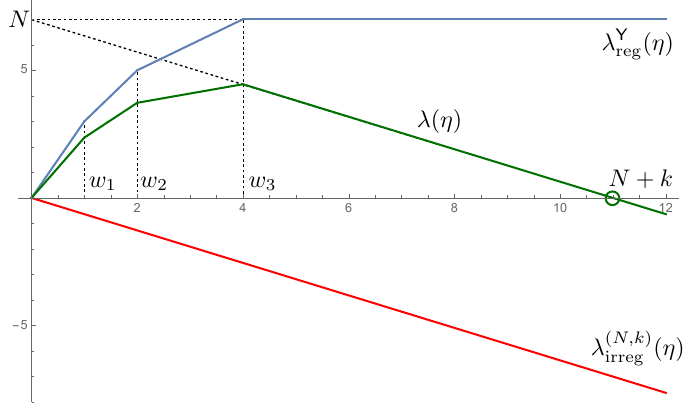
( η ) and reg ( η ) , and reg = 1 , w = 2 , w = 4 , k = k = k = 1 , 1 2 3 1 2 3